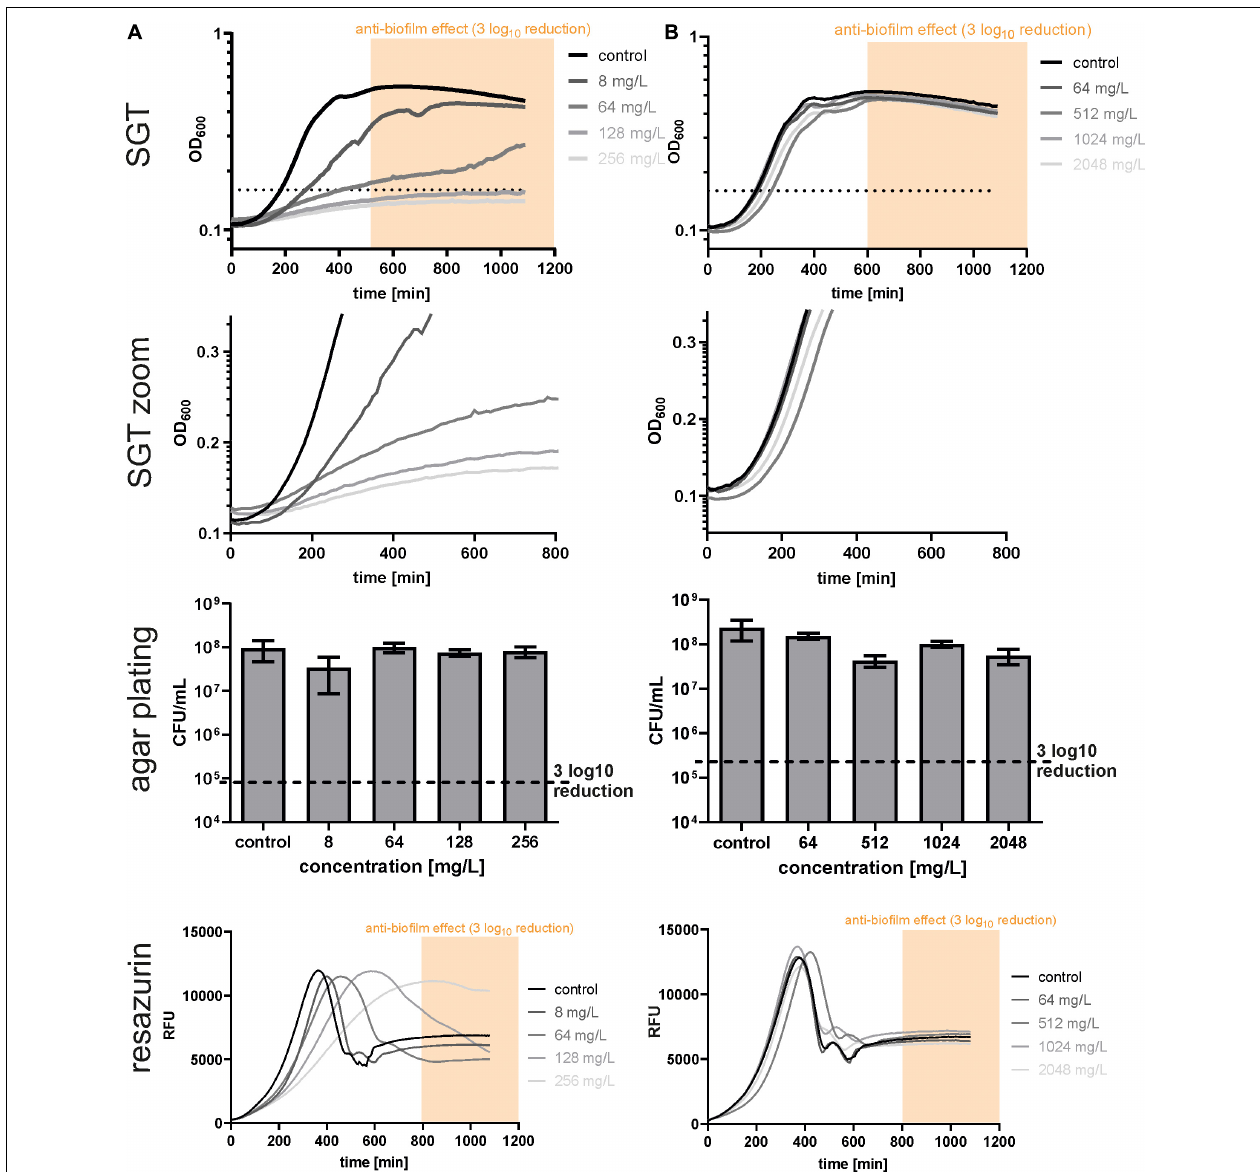
FIGURE 2 | Determination of biofilm bactericidal effects with the three different methods in EF17129 biofilms treated with dalbavancin (A) and gentamicin (B) . The yellow or orange window (“anti-biofilm effect”) indicates the area with an at least 3 log 10 reduction in CFU compared to the untreated control. The black dotted line indicates the OD threshold for SGT